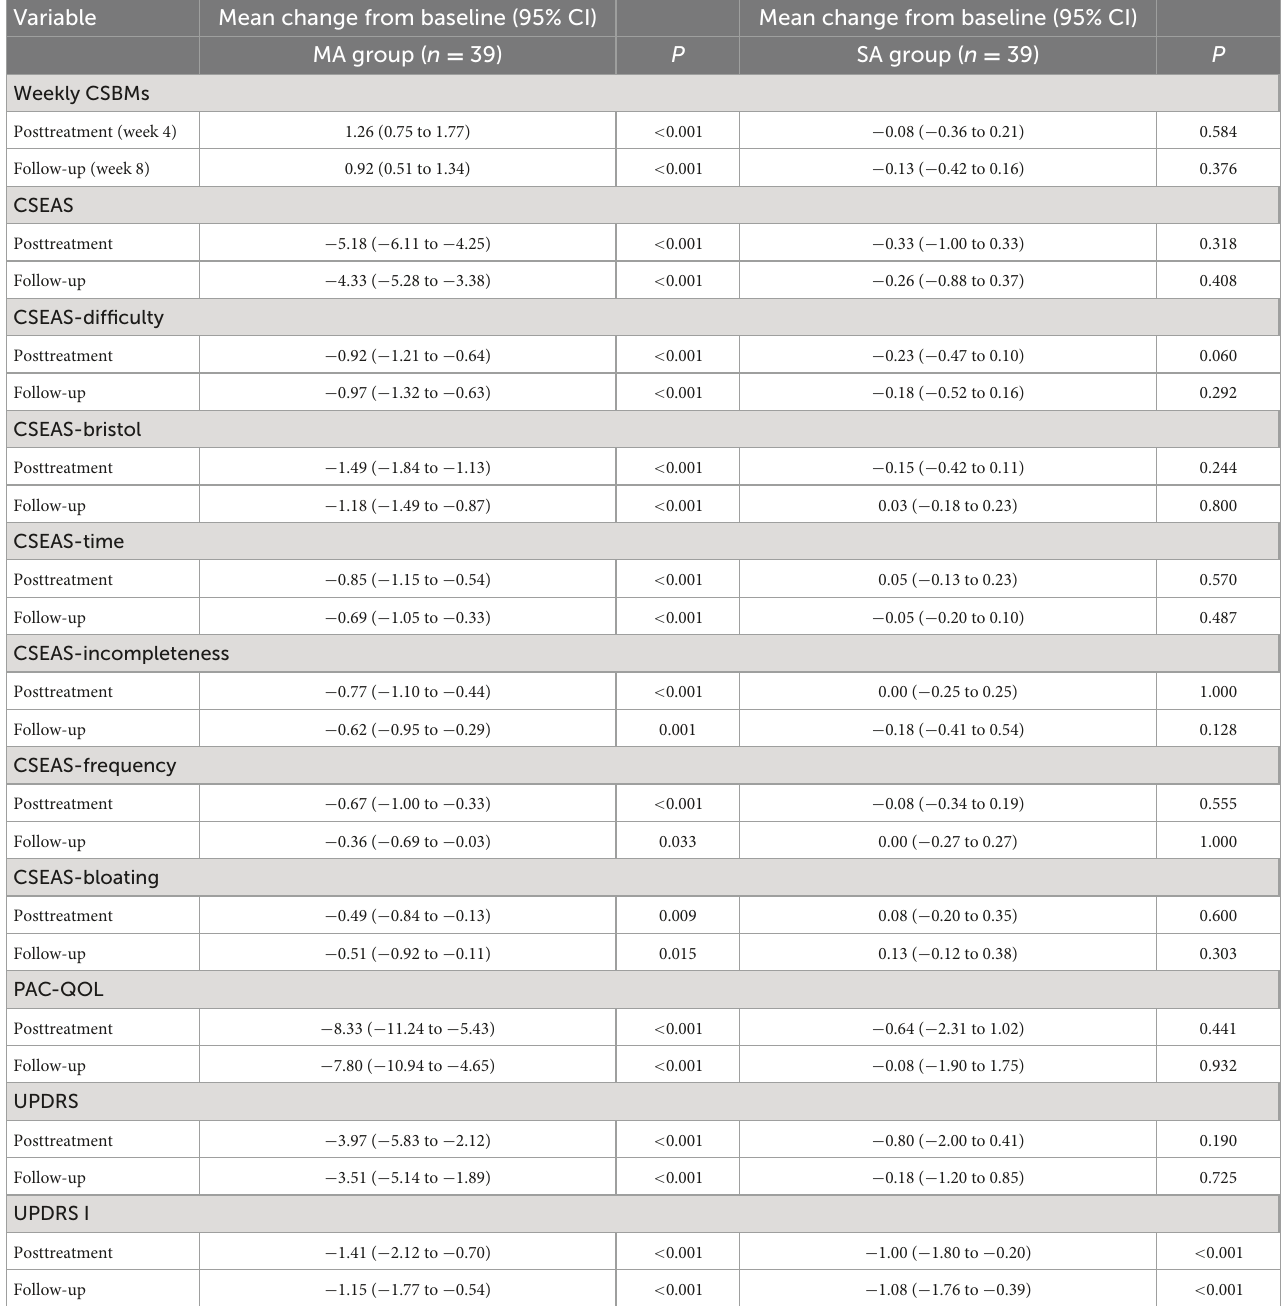
TABLE 3 Comparison of the primary and secondary outcomes from the baseline. Variable Mean change from baseline (95% CI) Mean change from baseline (95%